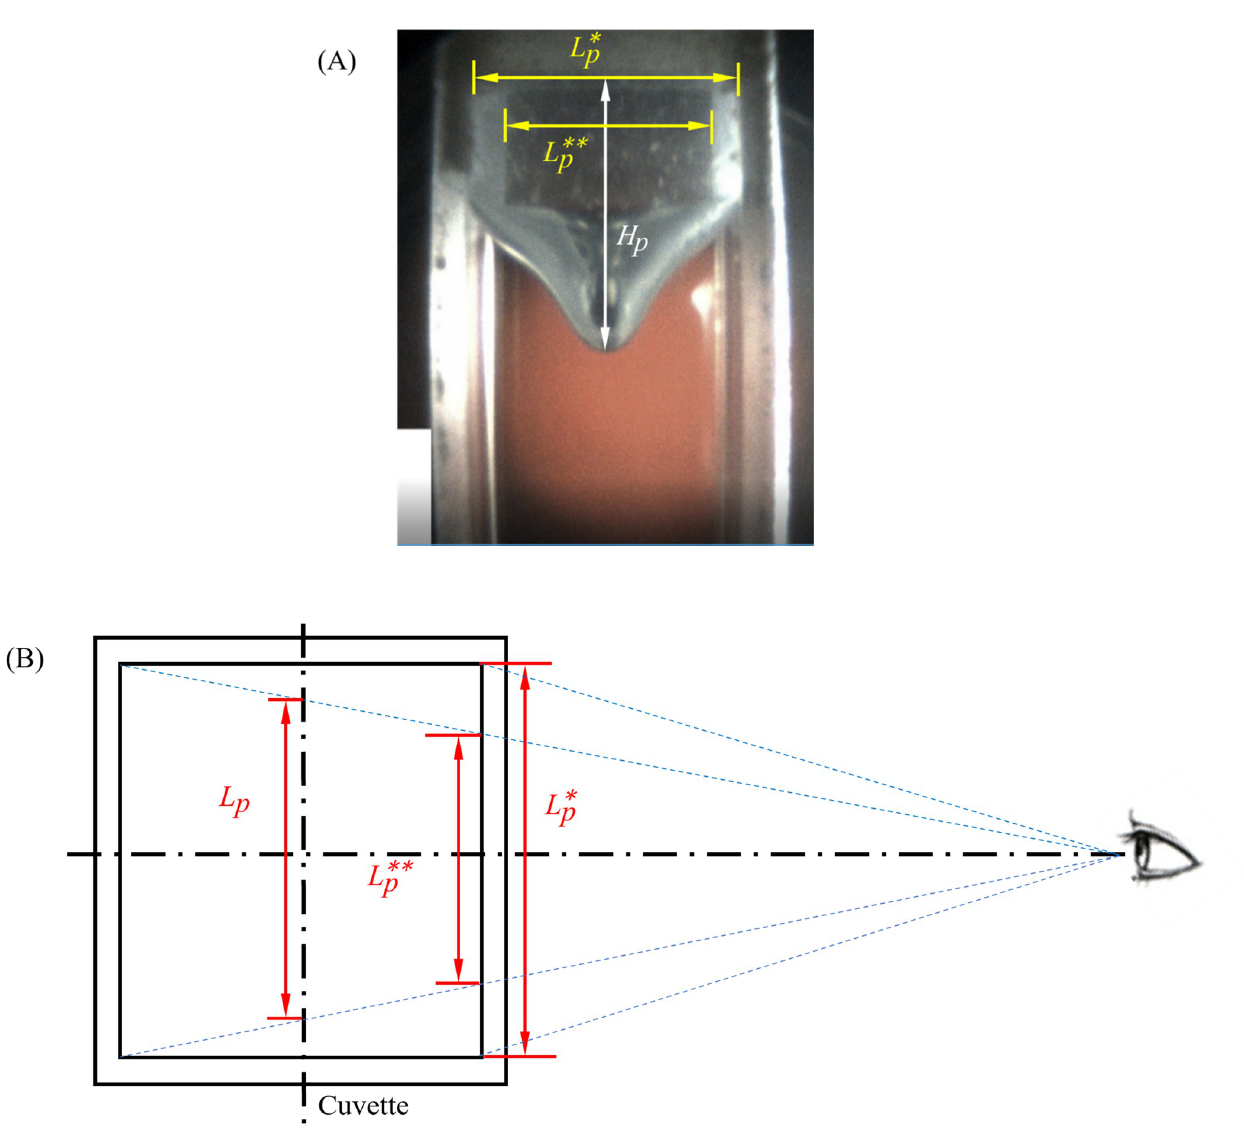
Fig 2. Parameters used for the analysis of experimental measurements, Eqs (1) and (2). (A) front view of the cuvette from the cryomacroscope, and (B) top view of the cuvette illustrating the scaling effect (not drawn to scale). The calculated inner width of the cuvette on the front face, Lp � , is 10.18 ± 0.11 mm for image in (A), while the experimentally measured width is 10 ± 0.1